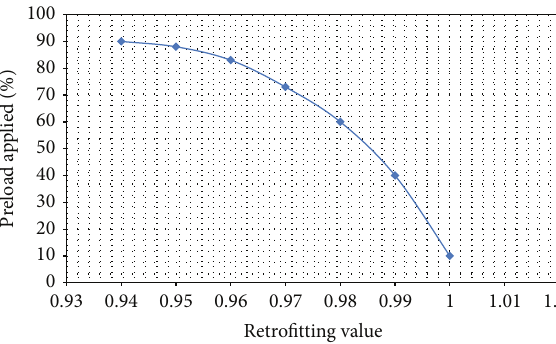
Figure 4: Retrofitting Constant 𝑅 𝑐 Value for compressive strength.